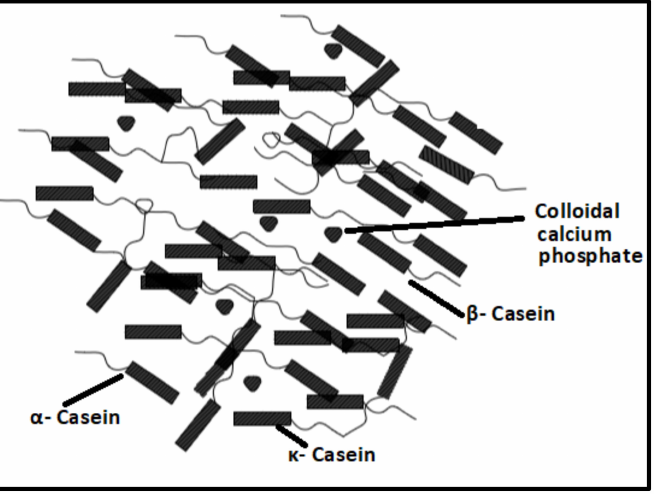
Figure 2. Casein polymer